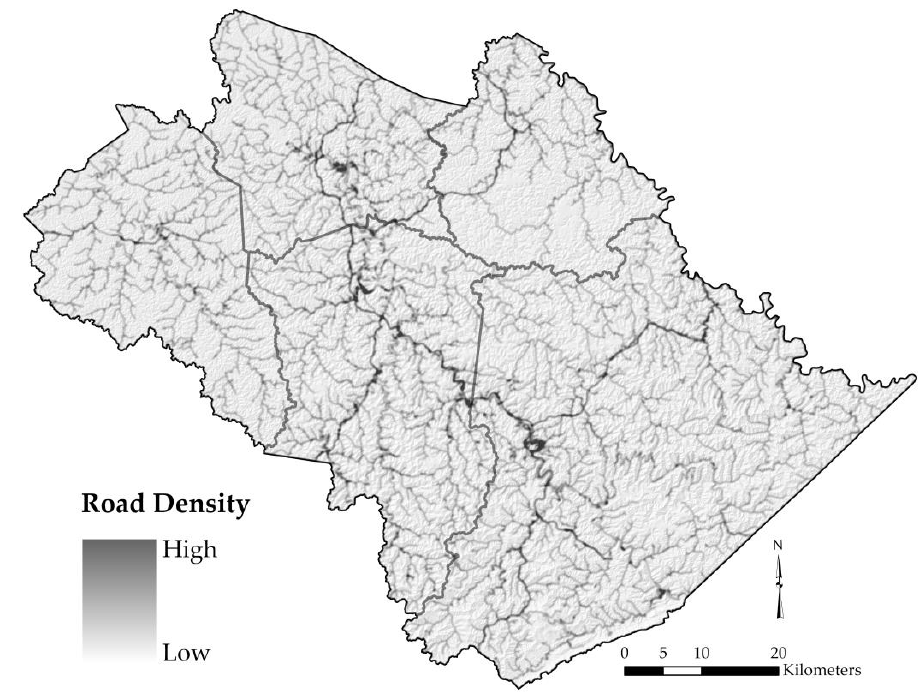
Figure 7. Kernel density map of state and local roads for the Big Sandy Area Development District. The low to high range of density classification represents the units of length of line per one square map unit.